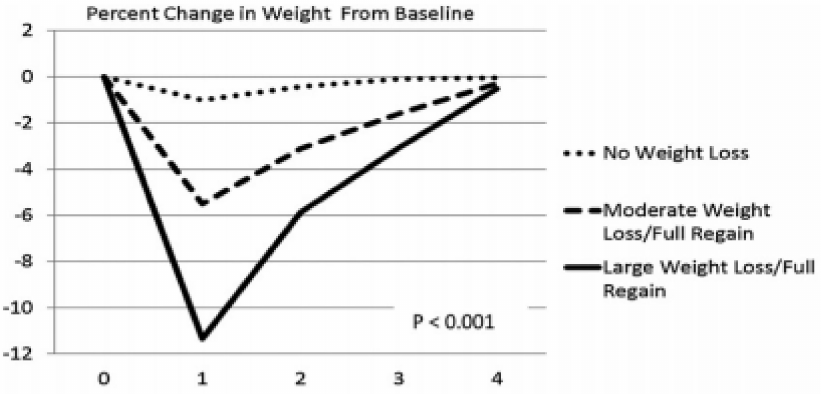
Figure 7. Percentage of post-weight-loss weight change over four years as a function of the magnitude of weight loss. From Wing, Espeland, Clark, Hazuda, Knowler, Pownall, Unick, Wadden, Wagenknecht. Association of weight loss maintenance and weight regain on 4-year changes in CVD risk factors: the action for health in diabetes (Look AHEAD) clinical trial. Diabetes care 2016, 39,